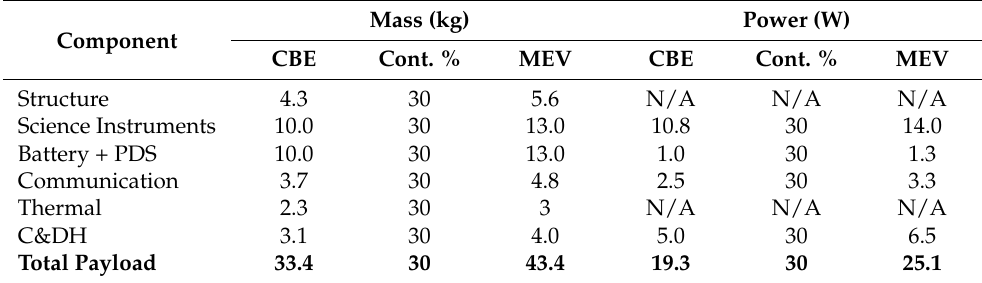
Figure 8. A schematic of a gondola for the VAIHL Lite Mission. Non-science subsystems, except for the antenna, are not shown. Table 3. VAIHL Lite Mission gondola mass and power